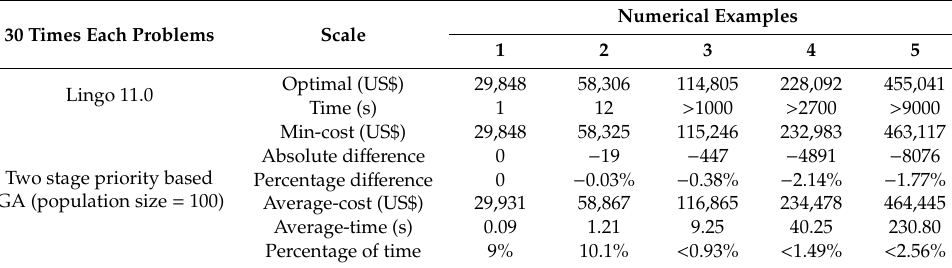
Table 4. Comparison between the proposed approach and